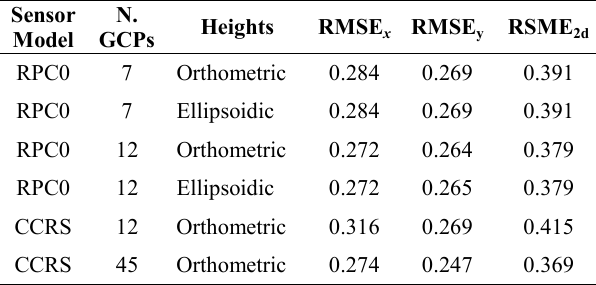
Table 2. Accuracy at the 69 ICPs for the sensor orientation phase. Values expressed in meters.